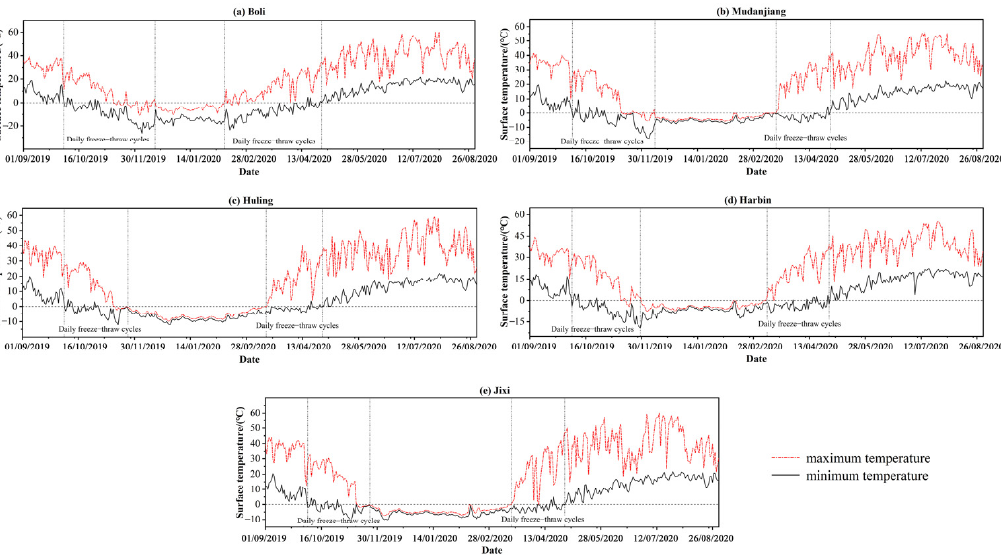
Figure 9. Changes in ground temperature during freeze–thaw cycles at representative sites of different vegetation types.